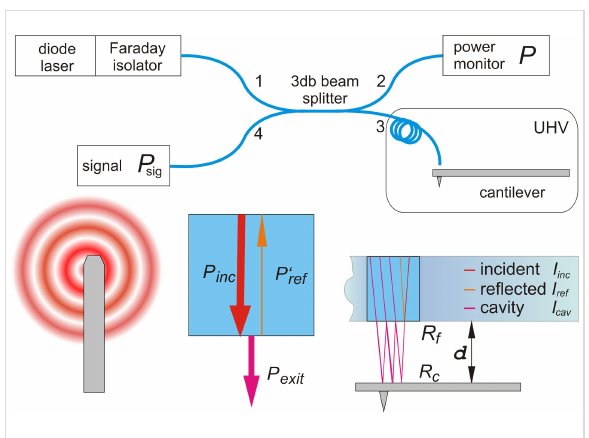
Figure 2: Schematic representation of the interferometer setup, signal path and cavity parameters. Signal power P sig and power monitor P are either measured with a power meter or processed with a balanced photo detector for low-noise detection of dynamic